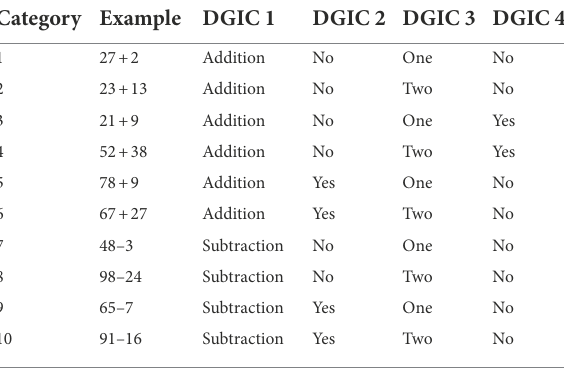
TABLE 3 Sample items illustrating different types of items based on the four